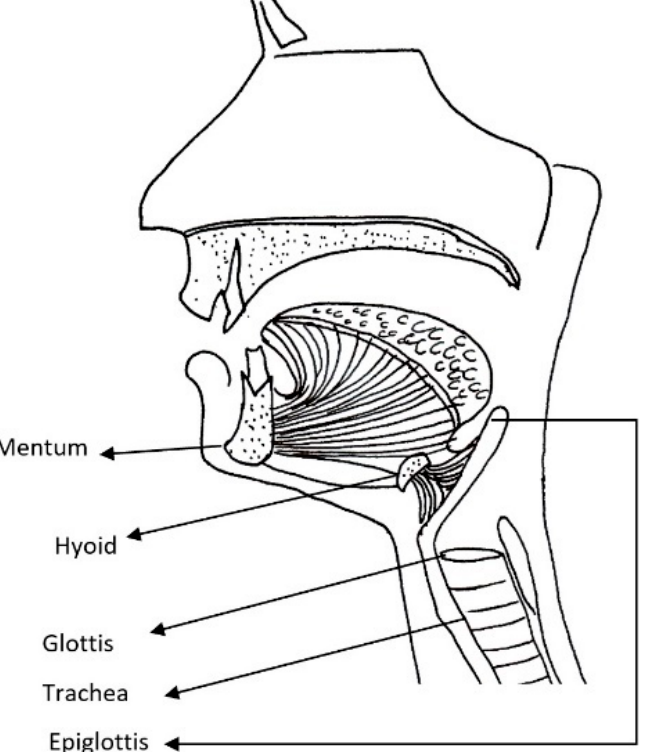
Figure 4. Line diagram sagittal section of the head and neck showing the upper airway and landmarks.